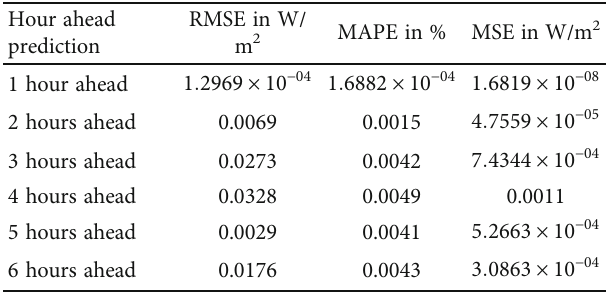
Table 2: The proposed CLSTMN-based results on cloudy datasets for di ff erent hour ahead prediction of solar